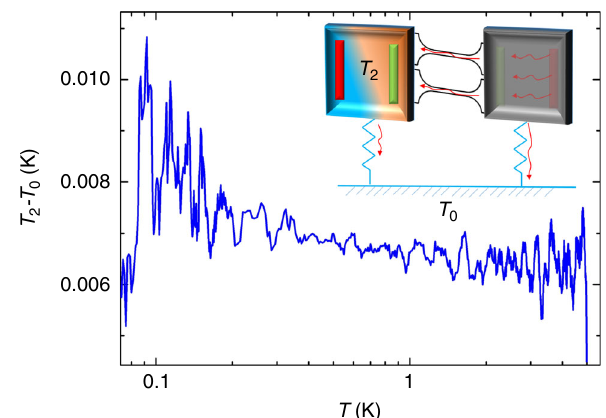
Fig. 7 Typical temperature gradient measured between the second membrane and the thermal bath (baseline) during an experiment of thermal conductance as a function of temperature. The temperature gradient is smaller than 10 mK. In inset, schematic of measurement con fi